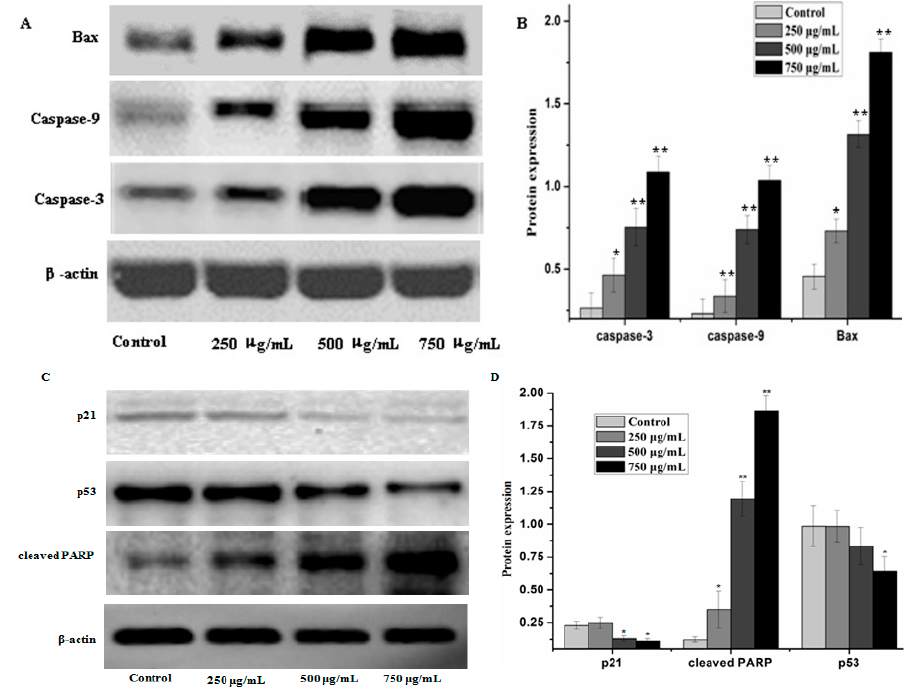
Figure 6. PZH-induced activation of caspase-3, caspase-9, p21, p53, cleaved-PARP and regulation pro-apoptotic protein Bax. The relative optical densities were indicated in B and D. Cells were treated with 250, 500 and 750 μ g/mL PZH for 24 h and then were lyzed for the determination of the indicated protein levels by western blot. Actin was used as internal control. * p < 0.05, ** p < 0.01 vs. control group. Data are mean ± SD. ( A ) Protein expresion of Bax, caspase-3 and caspase-9; ( B ) The relative optical densities of Bax, caspase-3 and caspase-9; ( C ) Protein expresion of p21, p53 and cleaved-PARP; ( D ) The relative optical densities of p21, p53 and cleaved-PARP.